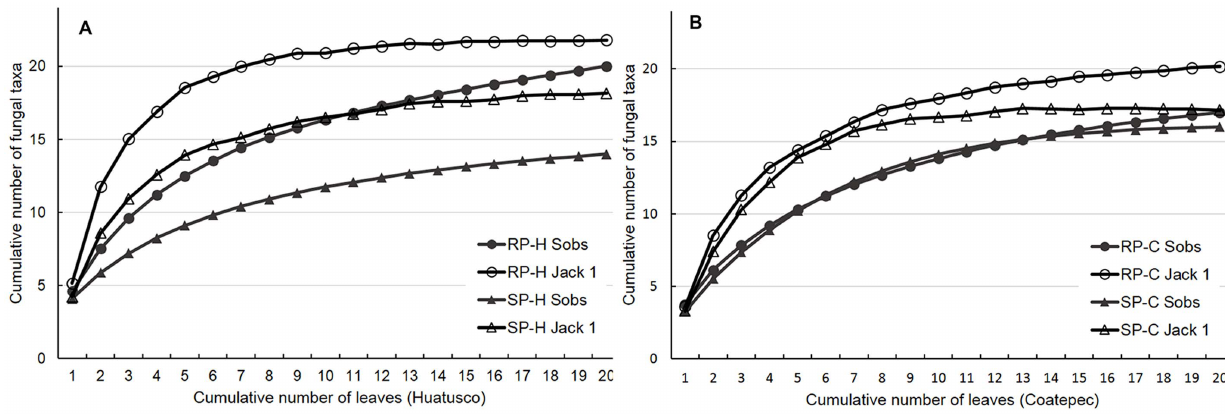
Figure 2. Rarefaction curves for fungal endophytes isolated from coffee leaves from the four coffee plantations. Species accumulation curves (gray circles and gray triangles) and Jackknife 1 estimated richness (open circles and open triangles) of rustic plantations (circles) and simple polycultures (triangles) of Huatusco region (A) and Coatepec (B). RP-H: rustic plantation Huatusco; RP-C: rustic plantation Coatepec; SP-H: simple polyculture Huatusco; SP-C: simple polyculture Coatepec.